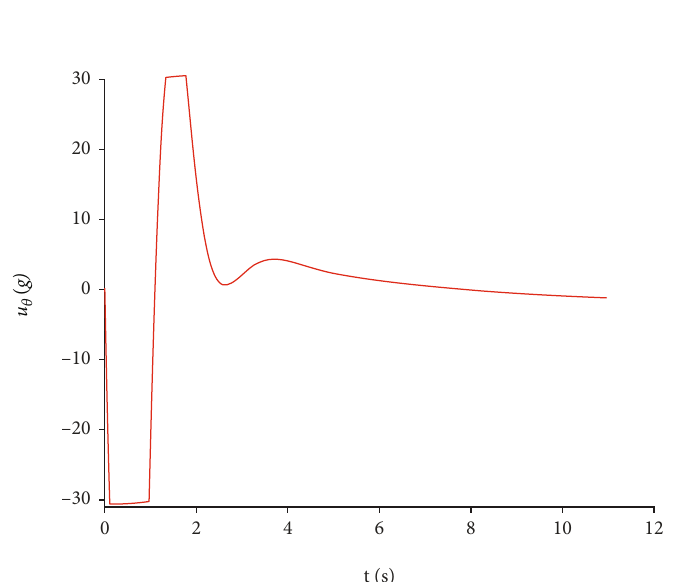
Figure 10: LOS angular rate curve.